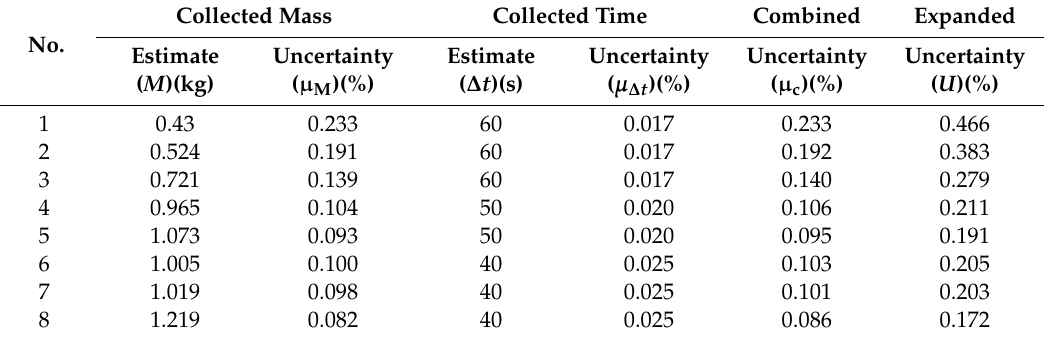
Table 4. Experiment uncertainty for laminar flow.